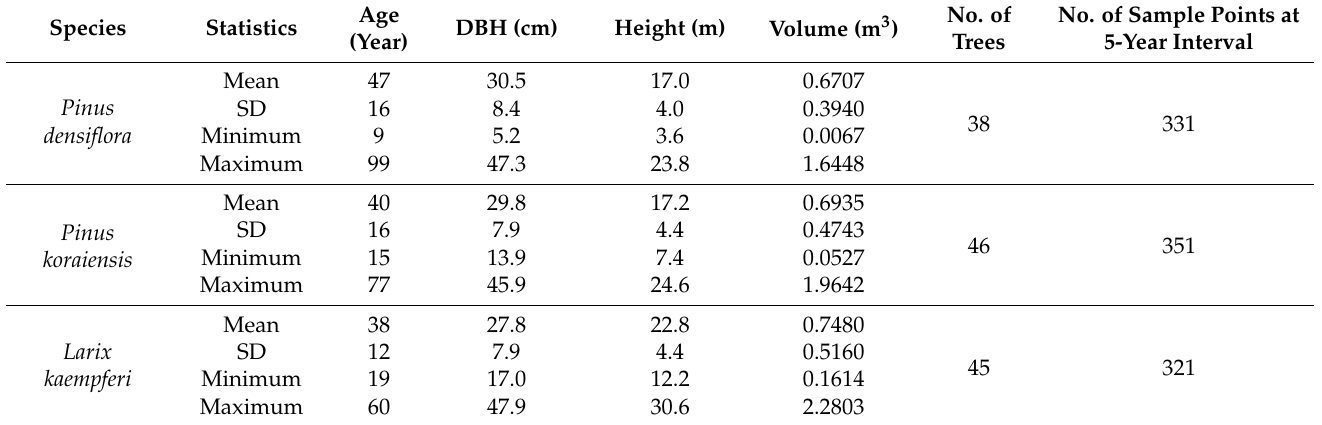
Table 1. Summary statistics of sample trees per species at the time of tree felling for stem